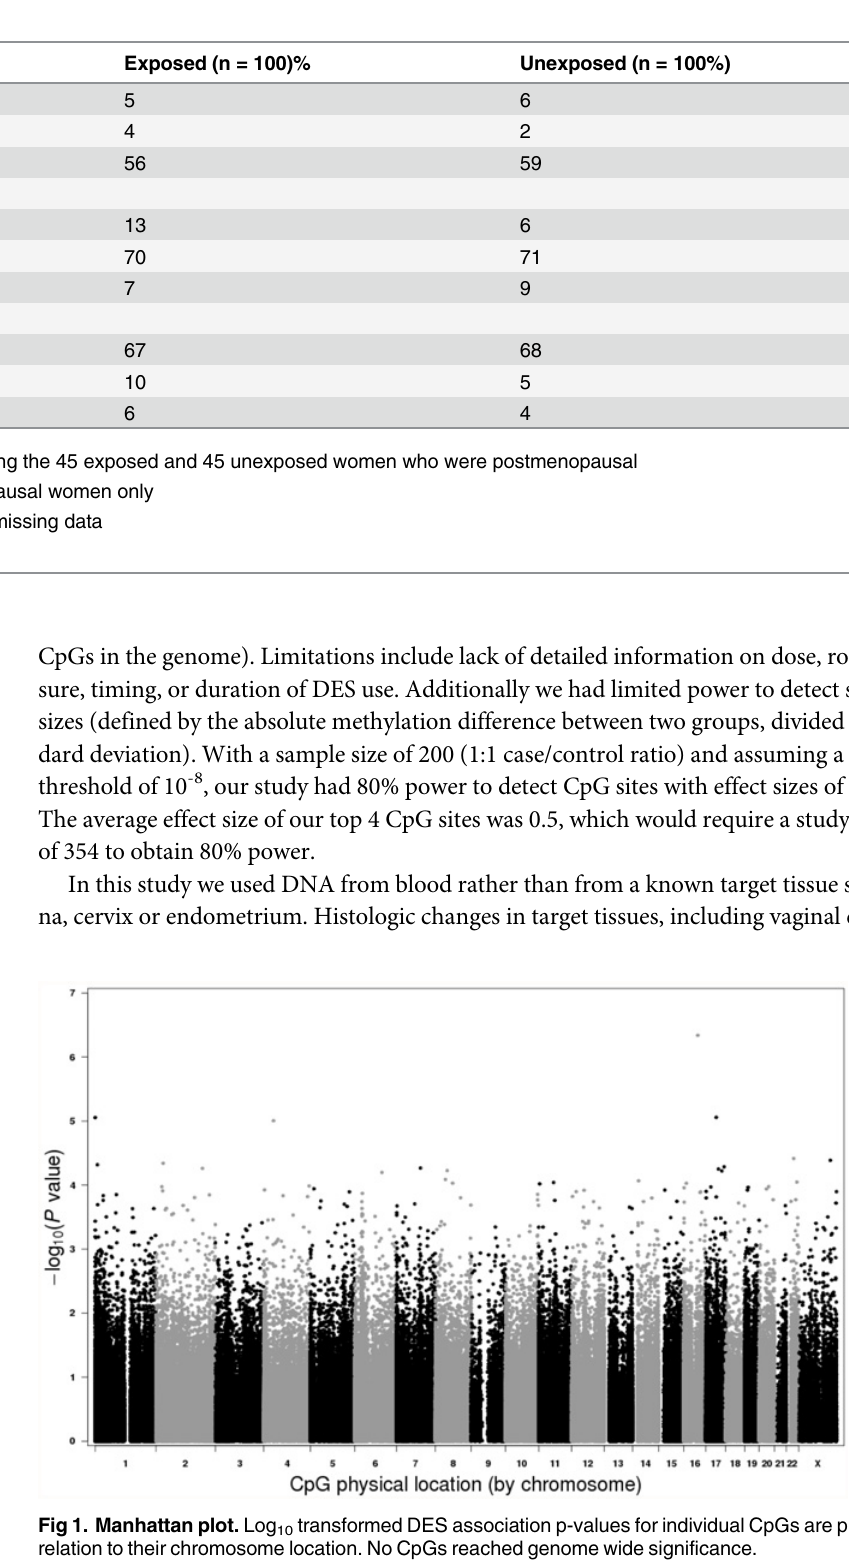
Fig 1. Manhattan plot. Log 10 transformed DES association p-values for individual CpGs are plotted in relation to their chromosome location. No CpGs reached genome wide significance.